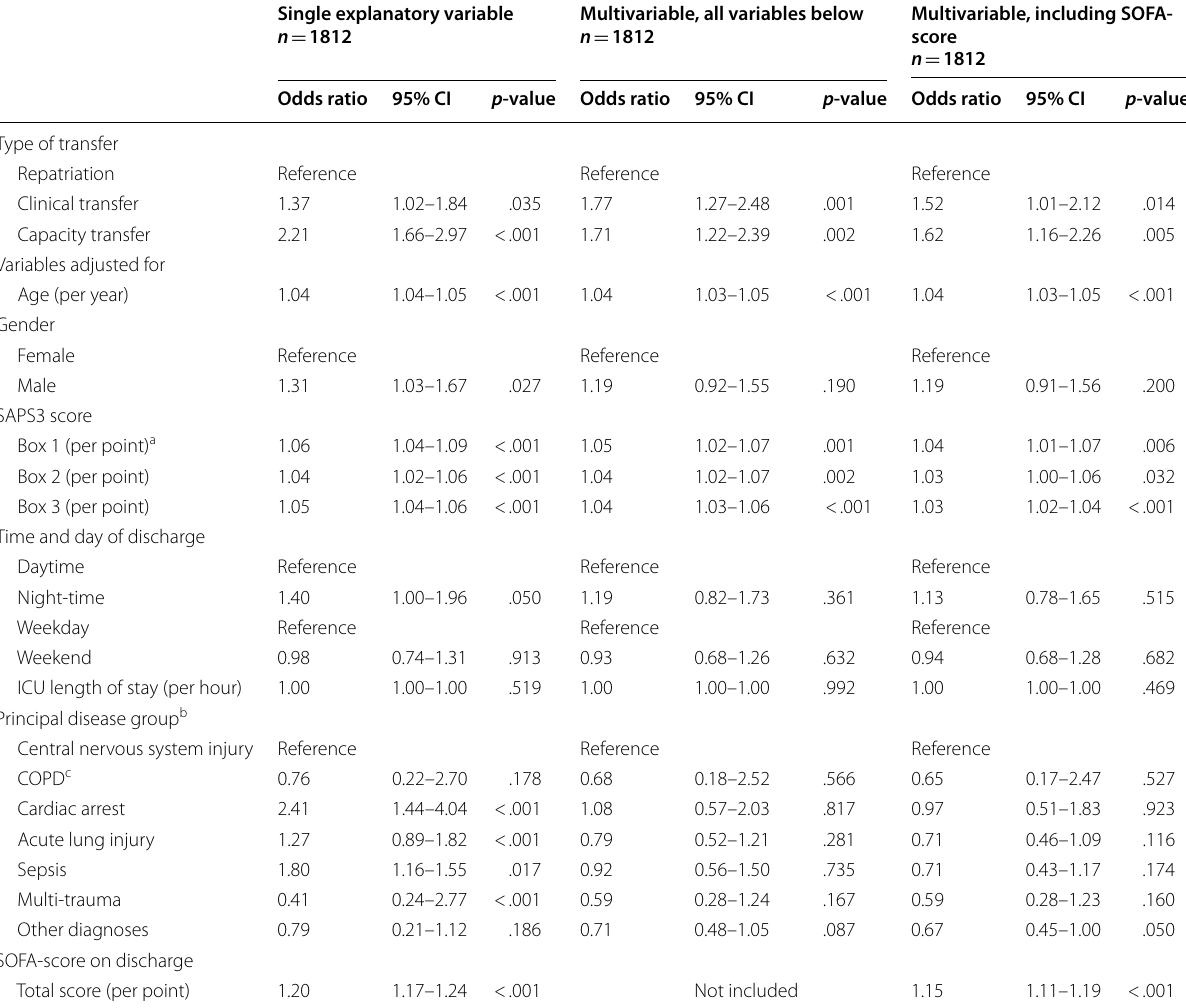
Table 3 Association between covariates and 30-day